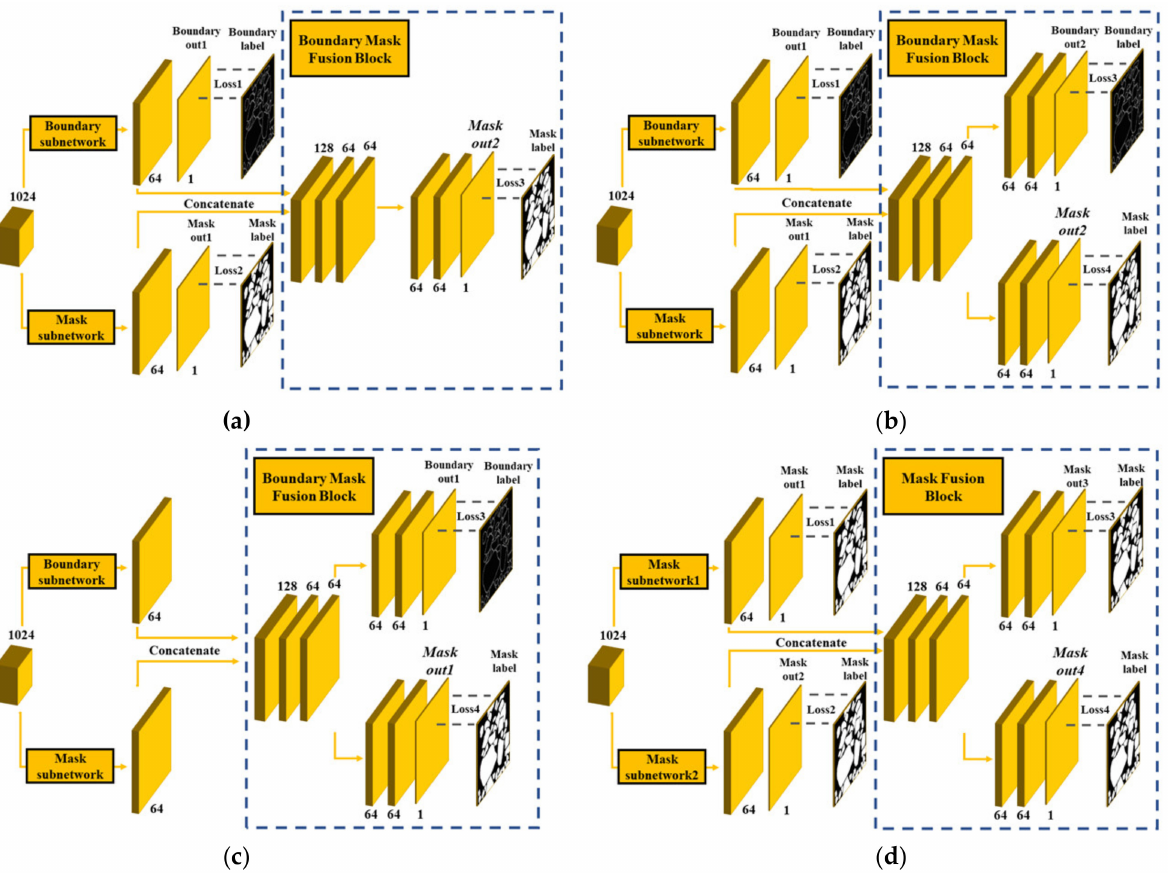
Figure 9. Simplified schematic diagram of the four models with different BMFBs: ( a ) the decoder of U-Net+res18+BA [27]; ( b ) the decoder of U-Net+res18 +dd; ( c ) the decoder of U-Net+res18+dd+loss3_4; and ( d ) the decoder of U- Net+res18+dd+mask. Table 5. Model comparisons of different boundary mask fusion blocks (BMFBs). The bold number means the best result. Acc F1 IOU_M Precision